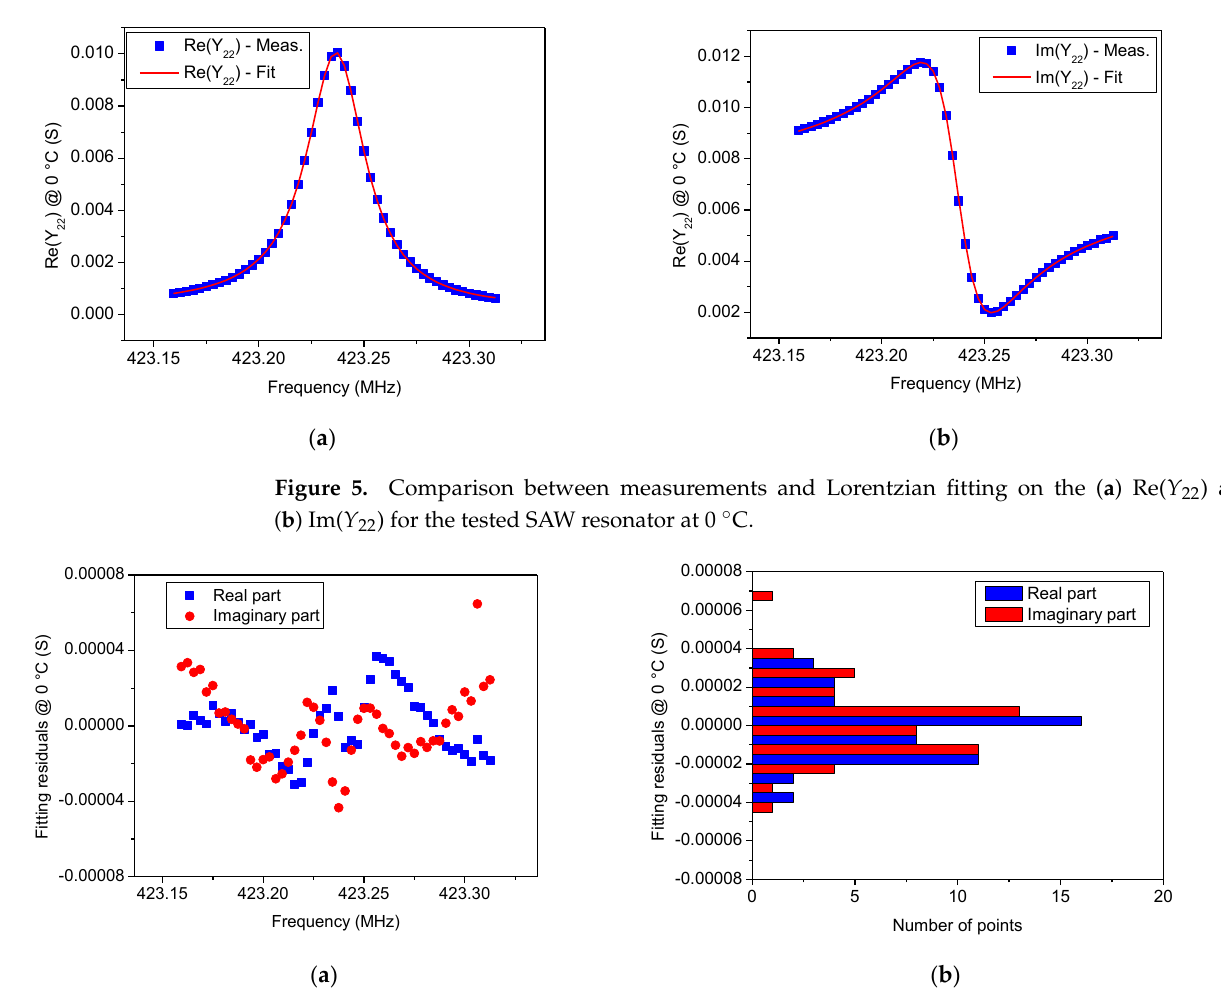
8 of 16 Figure 4. Diagram of the equivalent-circuit elements extraction process. In Figures 5–8 a comparison between the measured Y 22 and its fitted function is shown at 0 °C and 100 °C, respectively. Since Equation (14) describes a complex Lo-